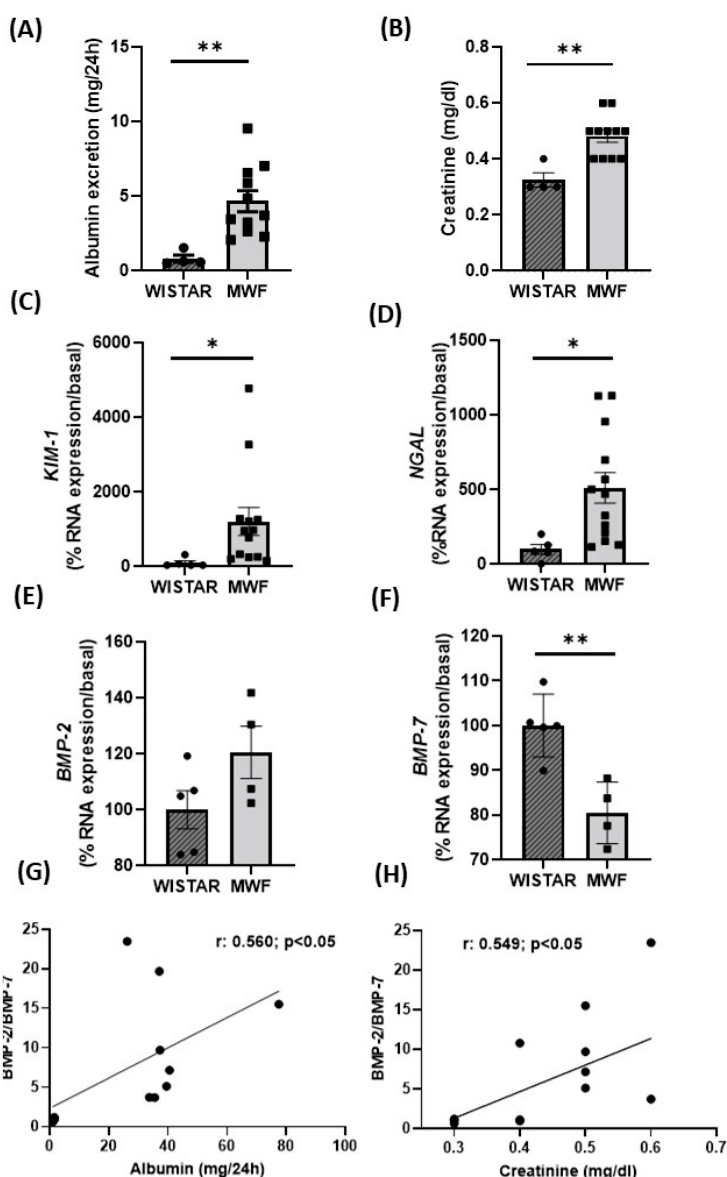
Figure 3. Renal function parameters in Wistar and MWF rats. ( A ) Urinary albumin excretion (UAE) and ( B ) creatinine plasma levels in Wistar and MWF rats. Renal mRNA expression of ( C ) KIM-1 , ( D ) NGAL , ( E ) BMP-2 , and ( F ) BMP-7 in Wistar and MWF rats. Correlation between the BMP-2/7 ratio and ( G ) urinary albumin excretion (UAE) or ( H ) creatinine plasma levels. Data are expressed as the mean ± SEM of n = 5–11 animals per group. * p < 0.05 and ** p < 0.01 compared to Wistar.